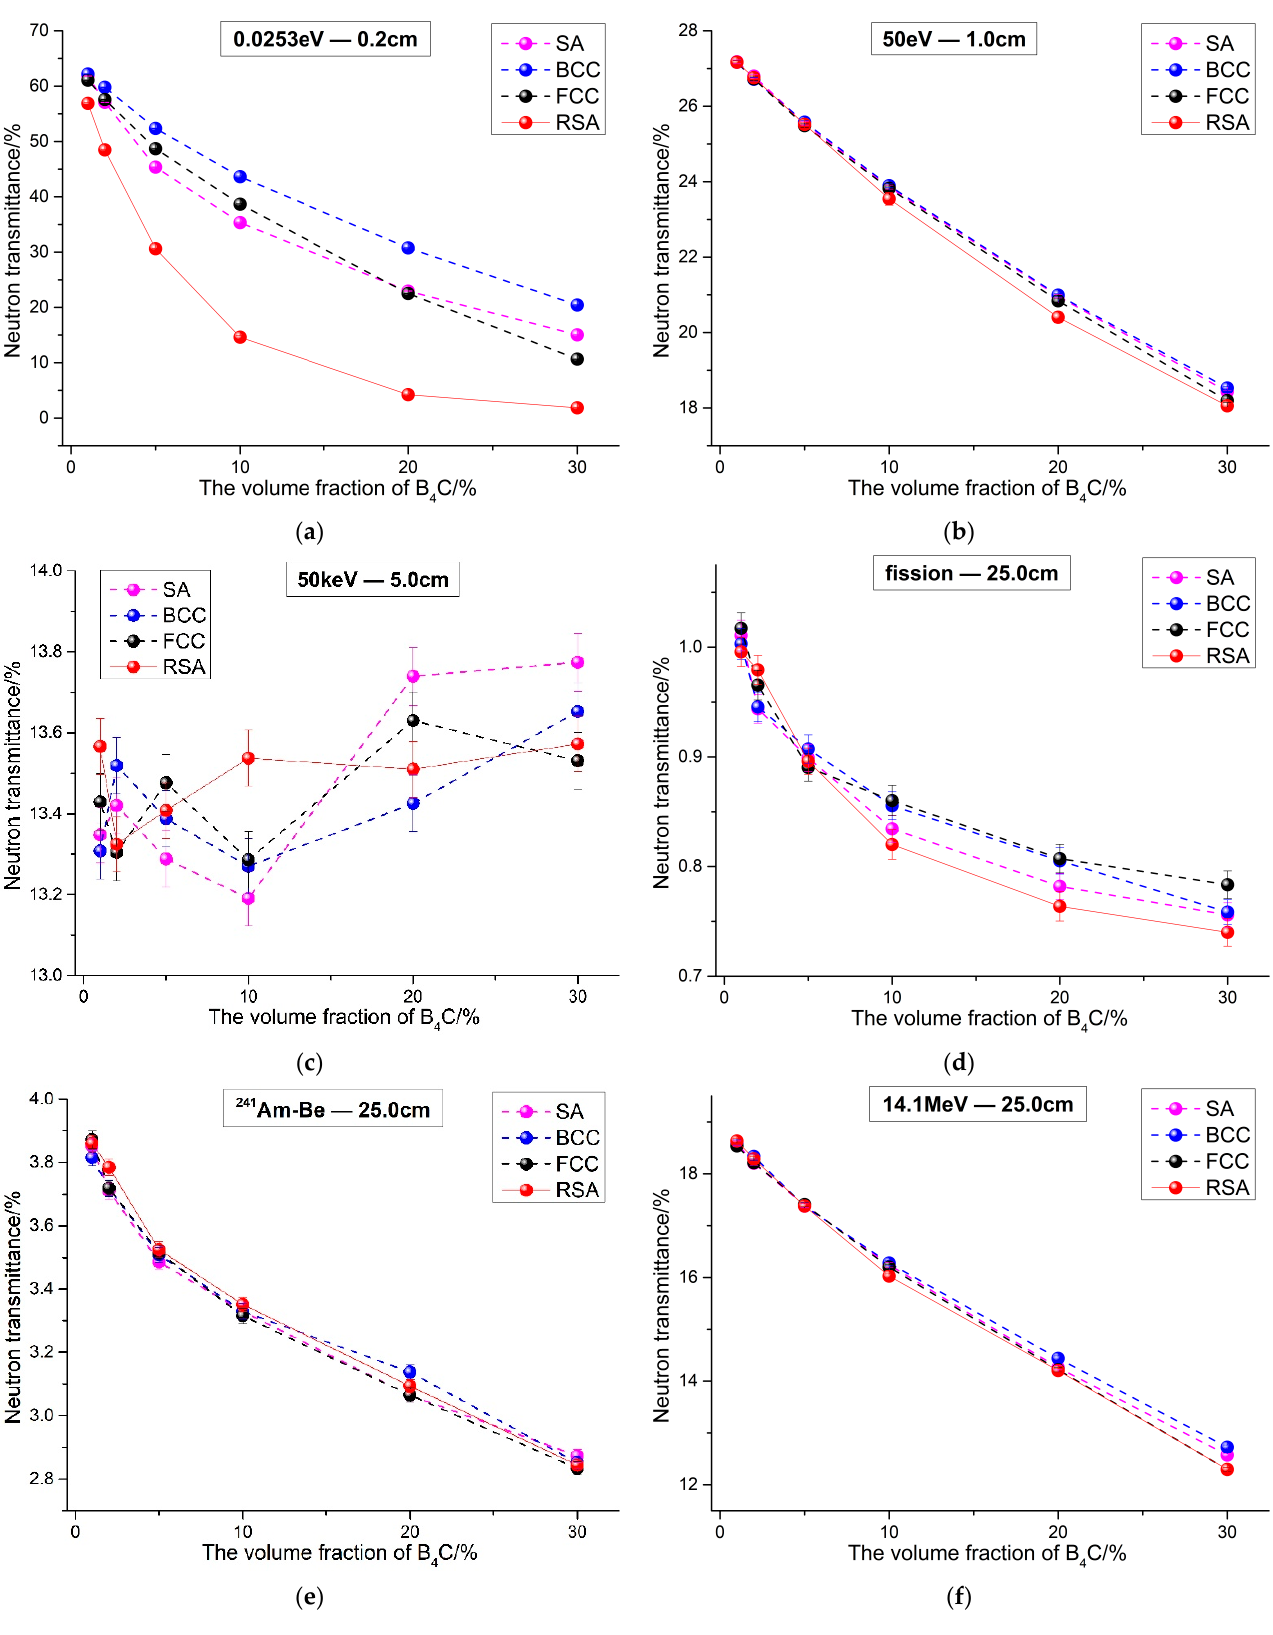
Figure 7. Neutron transmittance of B 4 C reinforced PE composite under different neutron energies. (( a ) 0.0253 eV; ( b ) 50 eV; ( c ) 50 keV; ( d ) fission spectrum; ( e ) 241 Am-Be spectrum; ( f ) 14.1 MeV).